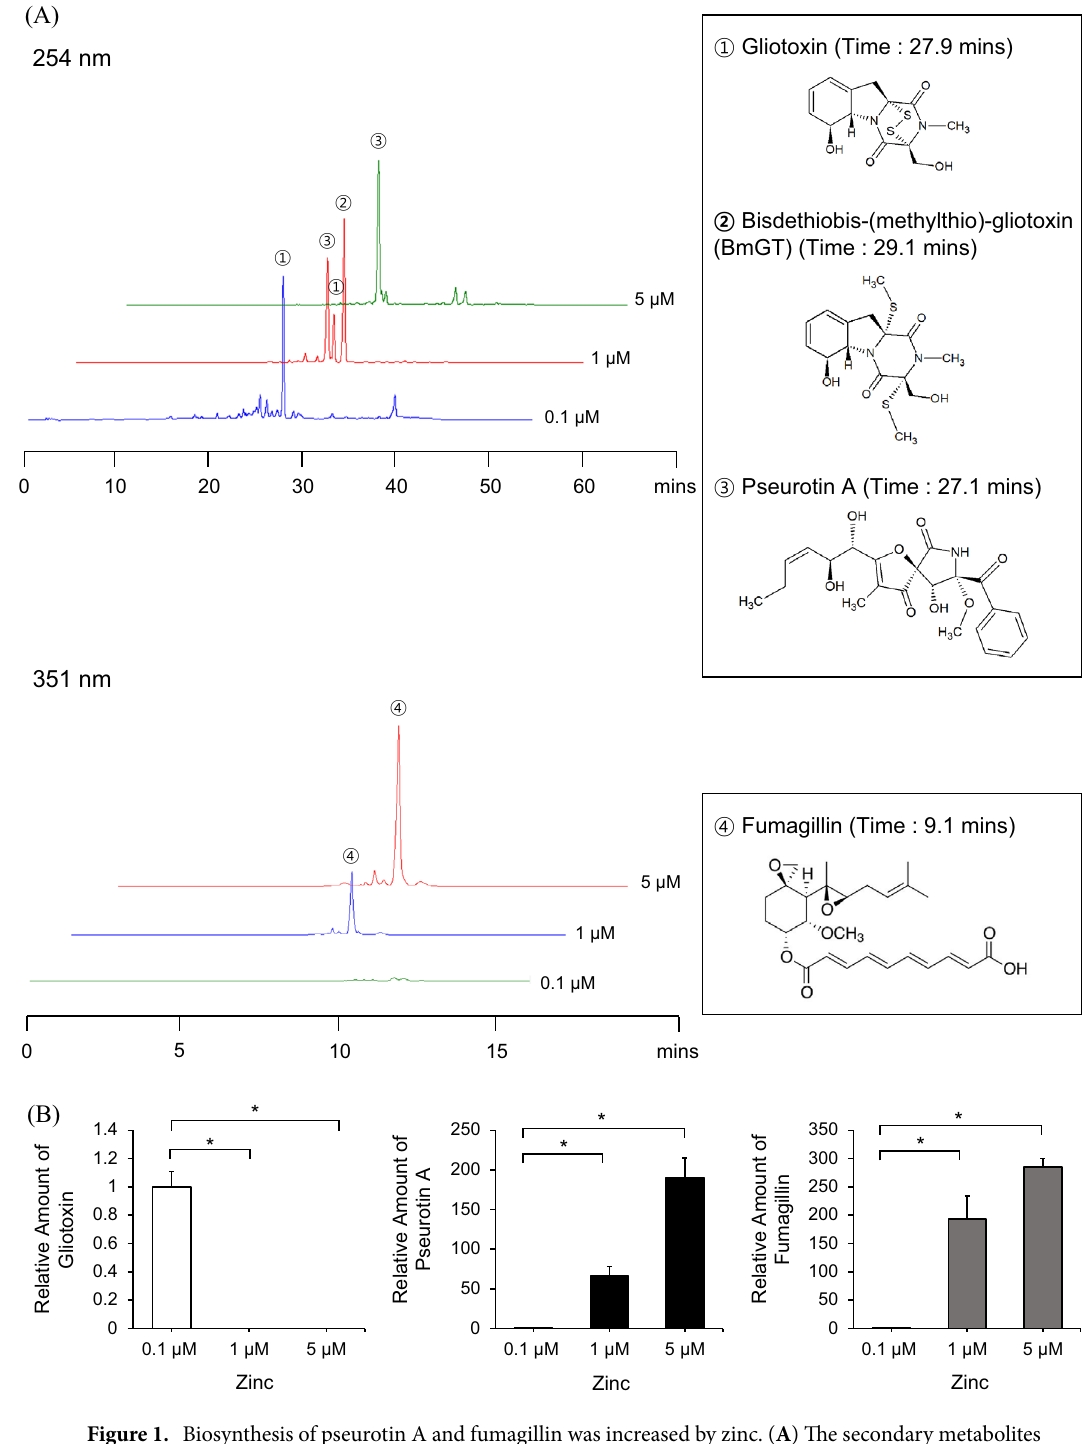
Figure 1. Biosynthesis of pseurotin A and fumagillin was increased by zinc. ( A ) The secondary metabolites were extracted from the culture media supernatant of the cells cultured at the indicated zinc concentrations and separated by HPLC. The peaks that appeared at the different retention times were fractionated, and structural analysis was performed using LC–MS (Supplementary Fig. S1). The different colored lines reflect different zinc concentrations (0.1, 1 and 5 μM zinc). The number of peaks corresponds to the molecular structure shown in the panel below. ( B ) The production amounts of the three HPLC fractions were quantified, and the amounts of secondary metabolites were compared. The white, black, and gray columns represent gliotoxin, pseurotin A, and fumagillin, respectively. * p < 0.05 indicates a significant difference compared to the control